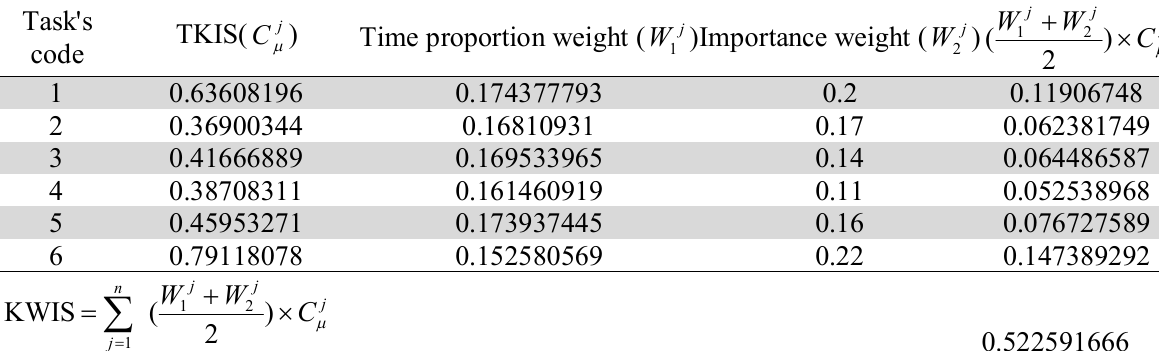
KWIS calculation for Laboratory